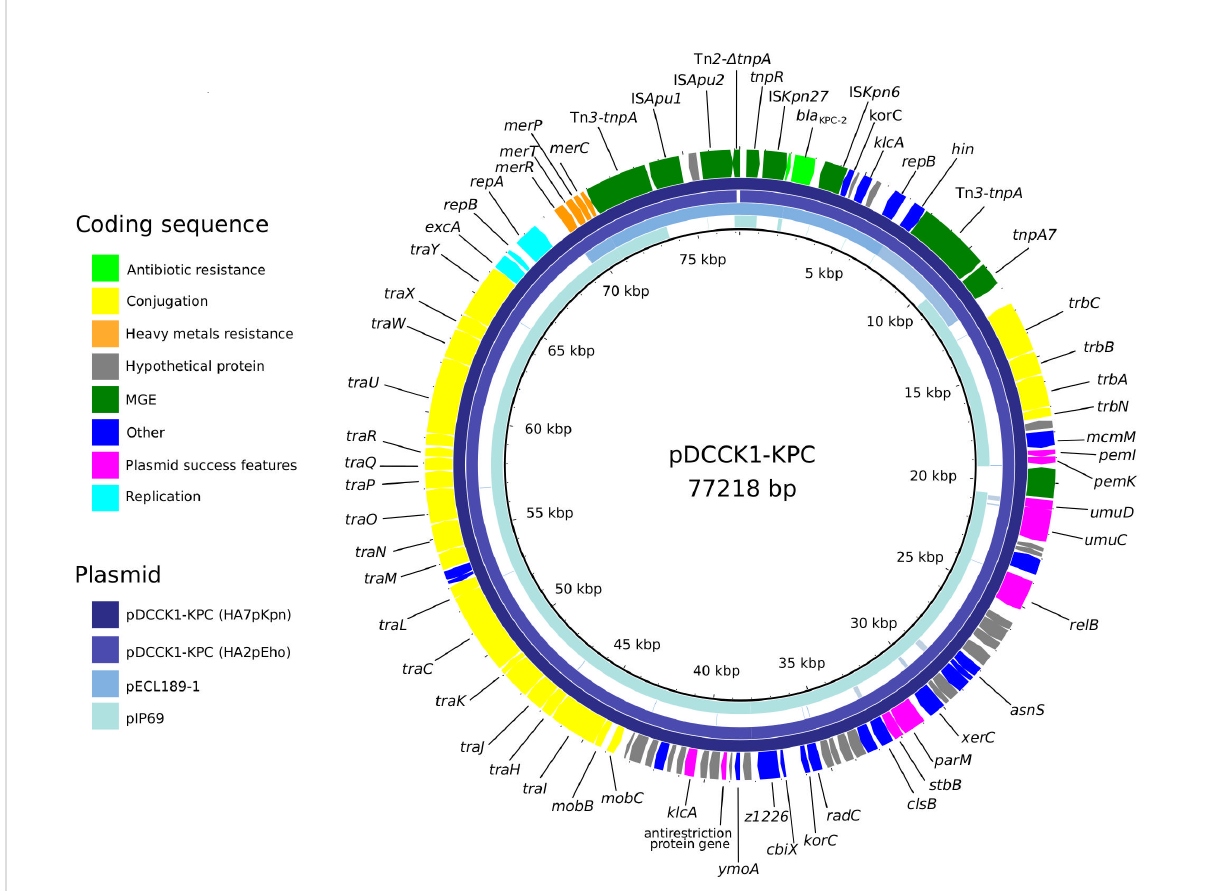
FIGURE 2 Fitness assays between KPC-ECC and KPC-Kp clones. KPC- E. hormaechei ST45 (HA2pEho), ST66 (HA58Eho), and ST78 (HAC11Eho) were set to compete with KPC- K. pneumoniae ST11 (HA15pKpn), ST18 (HA7pKpn), and ST258 (HA3pKpn). E. hormaechei ST45 and K. pneumoniae ST18 are the sequenced strains described in this study, and the other STs are high-risk clones found in our institution during a surveillance program (Table S1). In the cases where the values are above zero, it can be interpreted that ECC clones outcompete K. pneumoniae clones. The fi gure was made in R using the package